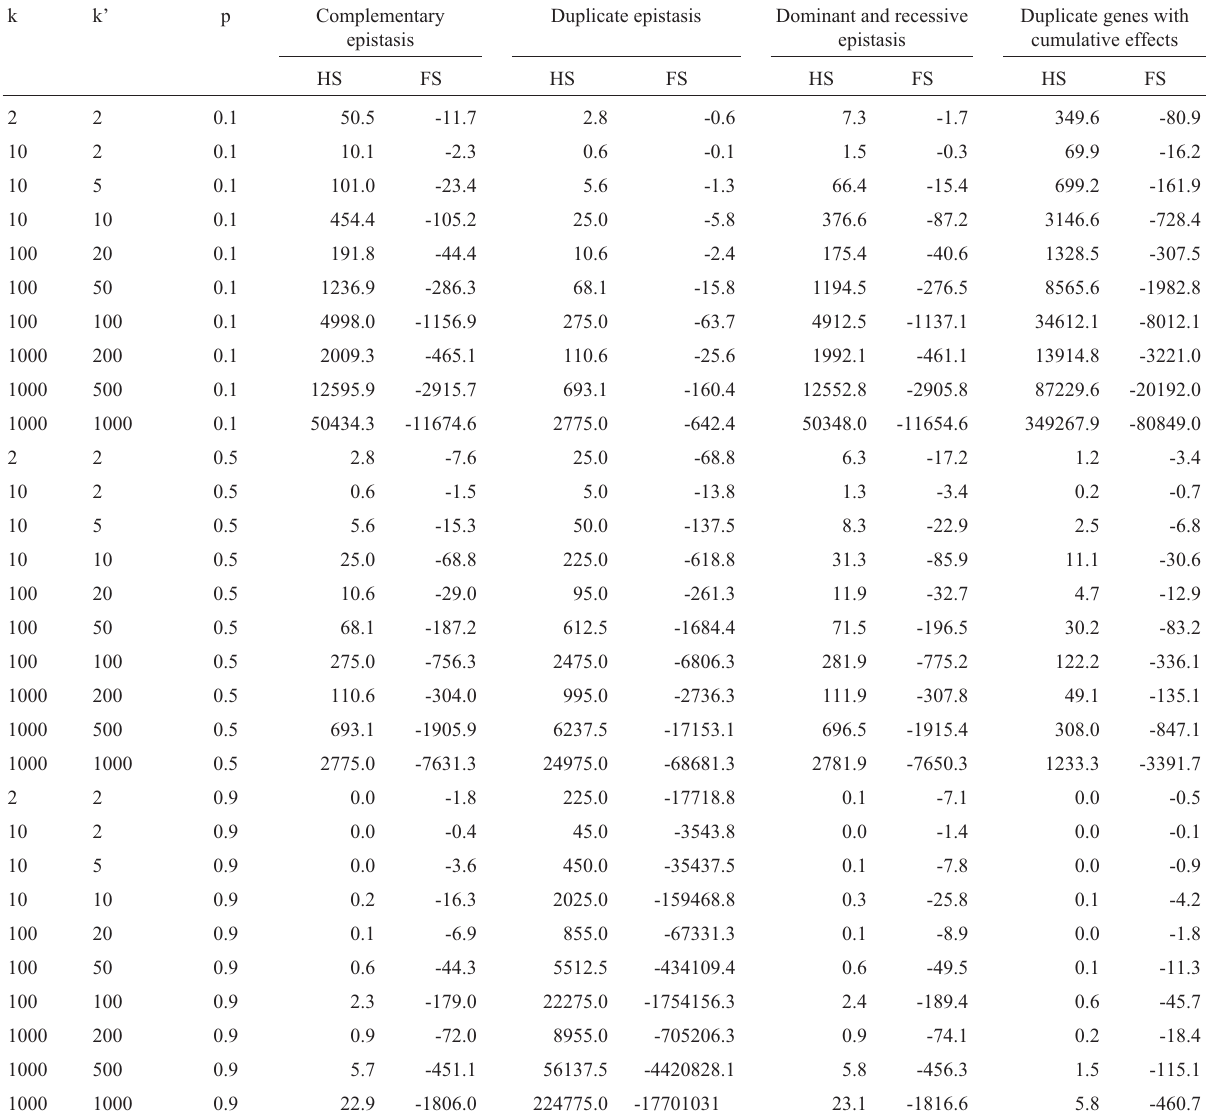
Table 3 - Bias (%) in the estimate of the additive variance because of the fitting of the additive-dominant model when there is digenic epistasis, considering half sib (HS) and full sib (FS) progenies, for different types of epistasis, polygenic systems (k is the number of genes and k’ is the number of genes that interact) and populations (p is the frequency of the dominant genes).